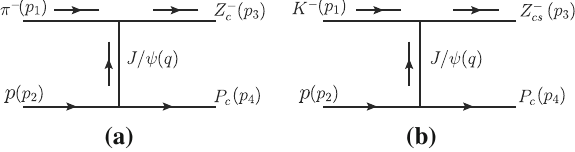
Fig. 1 A sketch diagram contributing to π − p → Z c ( 3900 ) P c (dia- gram a ) and K − p → Z cs ( 3985 ) P c (diagram b ), where P c can be P c ( 4312 ) , P c ( 4440 ) and P c ( 4457 ) , respectively Table 2 The values of the coupling constants estimated by the par- tial widths of the corresponding process. The error of these coupling constants are resulted from the uncertainties of the measured widths / 2 / 2 / 2 g 1 g 3 Coupling g 1 P c ( 4312 )ψ p P c ( 4440 )ψ p P c ( 4457 )ψ p Value 0 . 11 + 0 . 03 − 0 . 14 + 0 . 03 − 0 . 08 + 0 . 04 − 0 . 03 0 . 02 0 . 02 g Z Coupling g Z c ψπ cs ψ K Value 0 . 562 ± 0 . 026 0 . 364 + 0 . 09 − 0 .